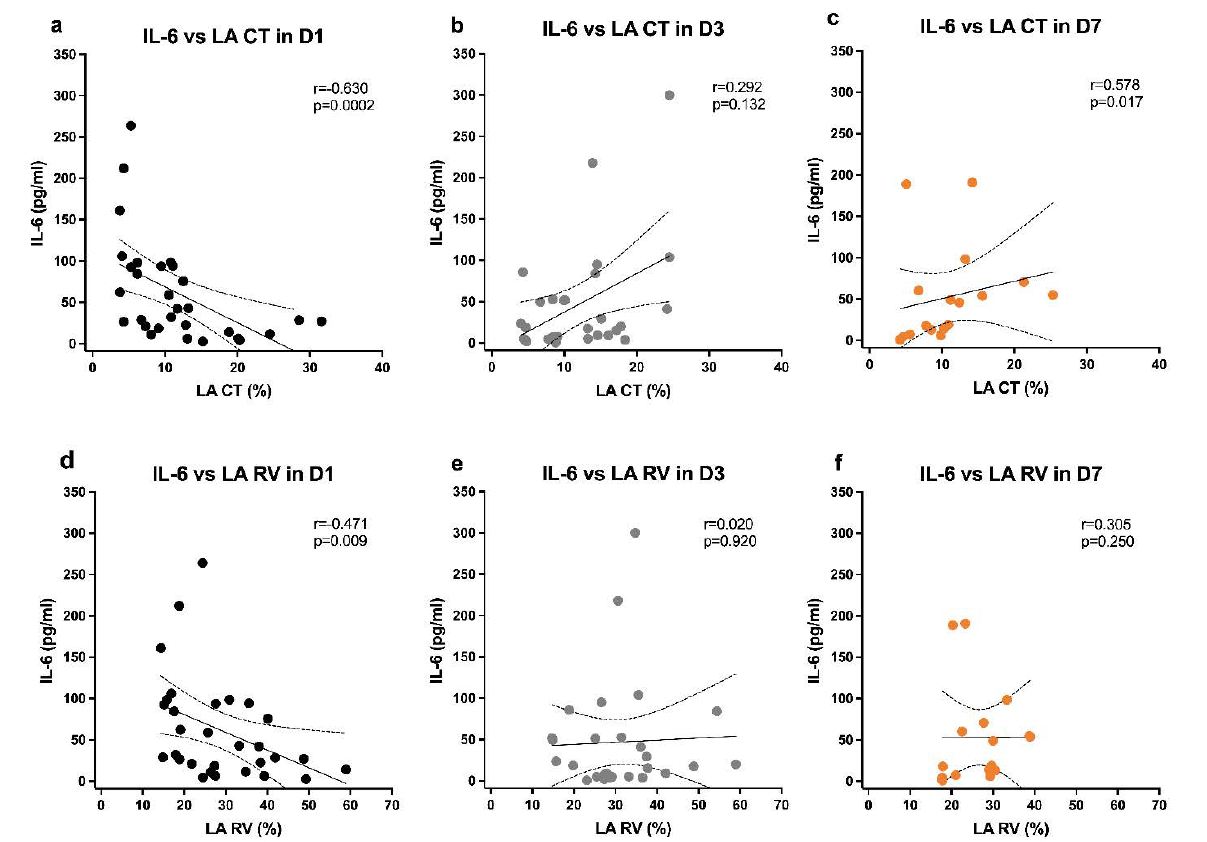
Figure 2. IL-6 levels correlations with LA CT and LA RV in all patients at time point D1 ( a , d ); D3 ( b , e ); and D7 ( c , f ); Spearman correlation coefficients, 95% confidence interval, and p -values are indicated. LA CT, left atrium strain contraction function; LA RV, left atrium strain reservoir